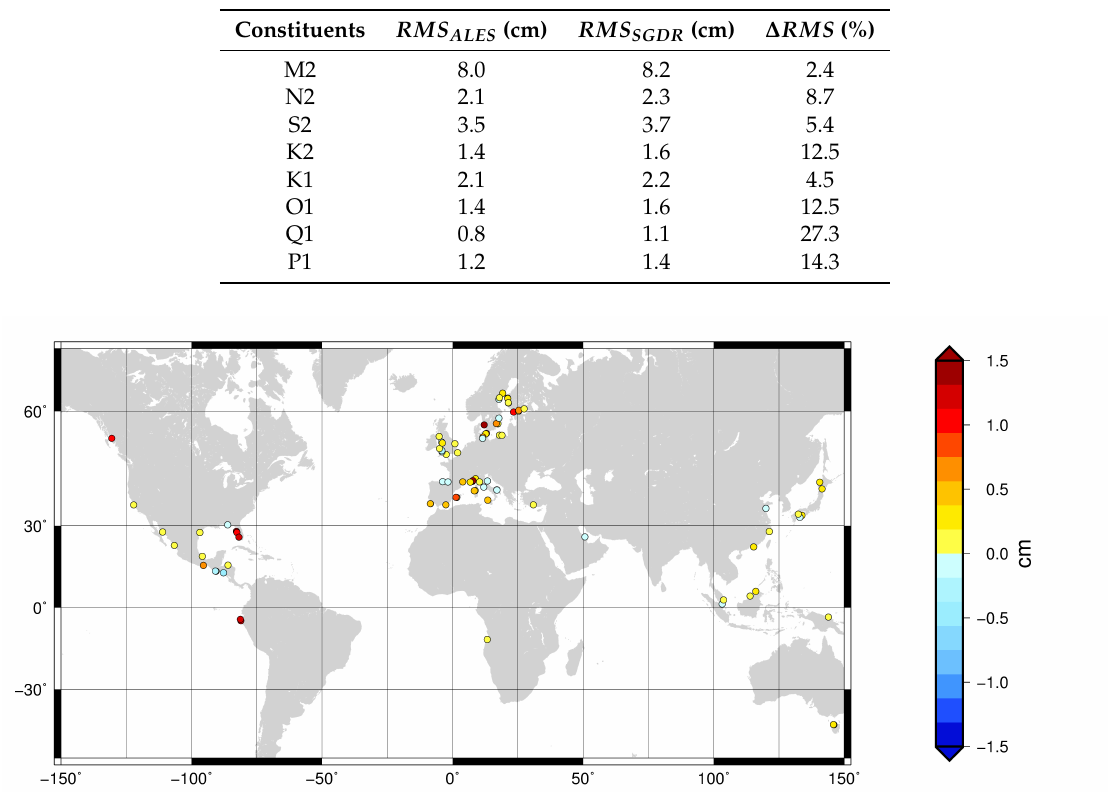
Figure 5. Geographical distribution of the ∆ RSS (in cm) for the closest nodes to the tide gauge of